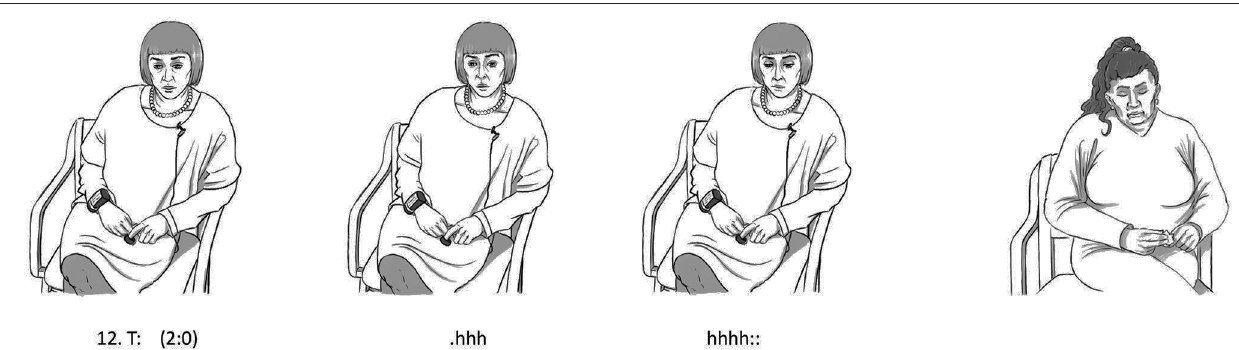
FIGURE 2 | Bodily actions in relation to example